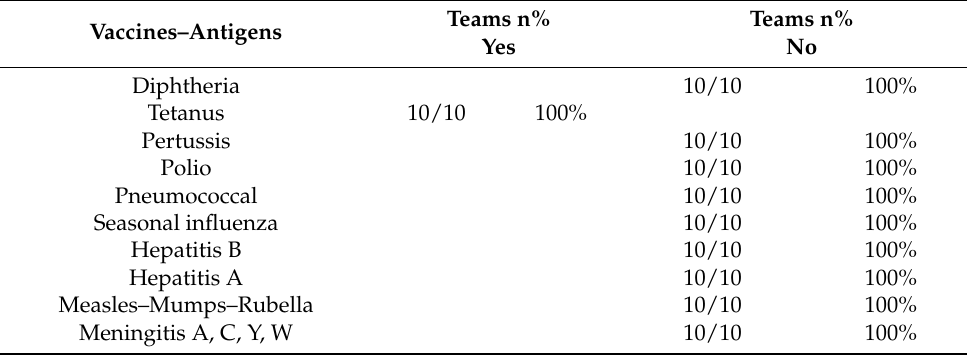
Table 1. Recommendations for vaccination in Football League